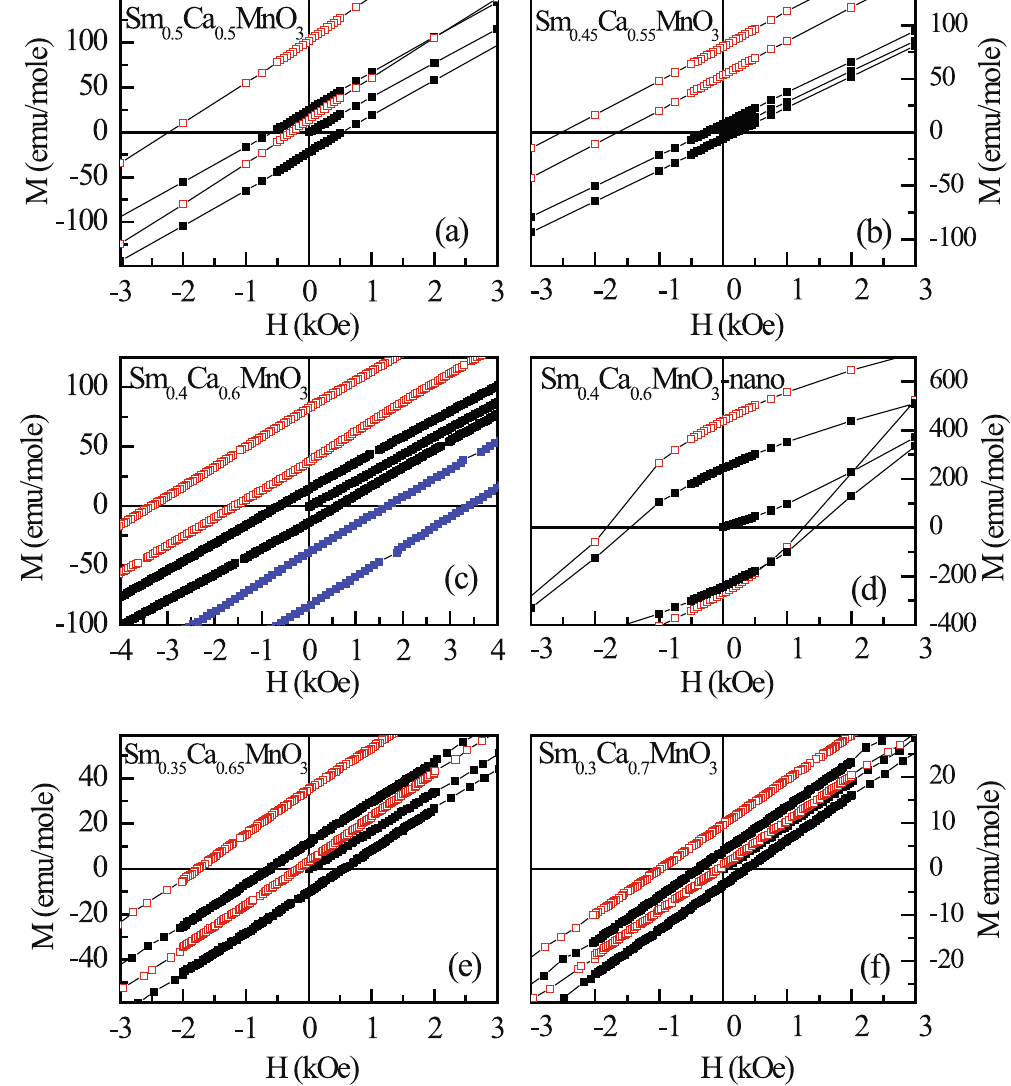
Figure 3. Magnetization as a function of external magnetic field for ( a – c , e , f ) bulk Sm 1 − x Ca x MnO 3 (x = 0.5, 0.55, 0.6, 0.65 and 0.7) and ( d ) Sm 0.4 Ca 0.6 MnO 3 - nano compounds at T = 5 K in ZFC (black symbol) and FC (red symbol) at H = 50 kOe, conditions used to measure exchange bias effect. An additional M(H) data for Sm 0.4 Ca 0.6 MnO 3 compound at T = 5 K in FC (H = − 50 kOe) protocol is also shown in ( c ) (denoted by blue